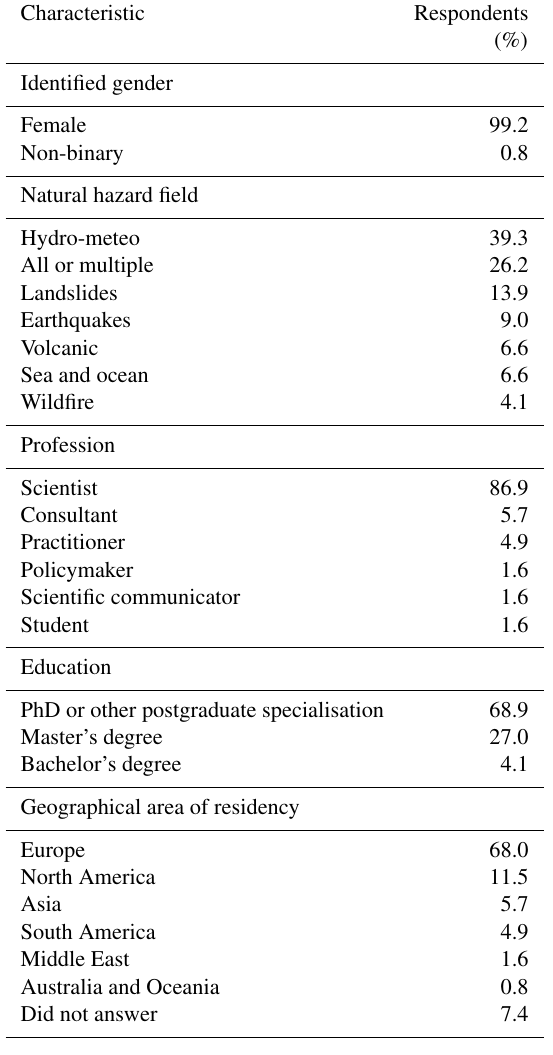
Table 1. Summary of the respondents’ demographics expressed in